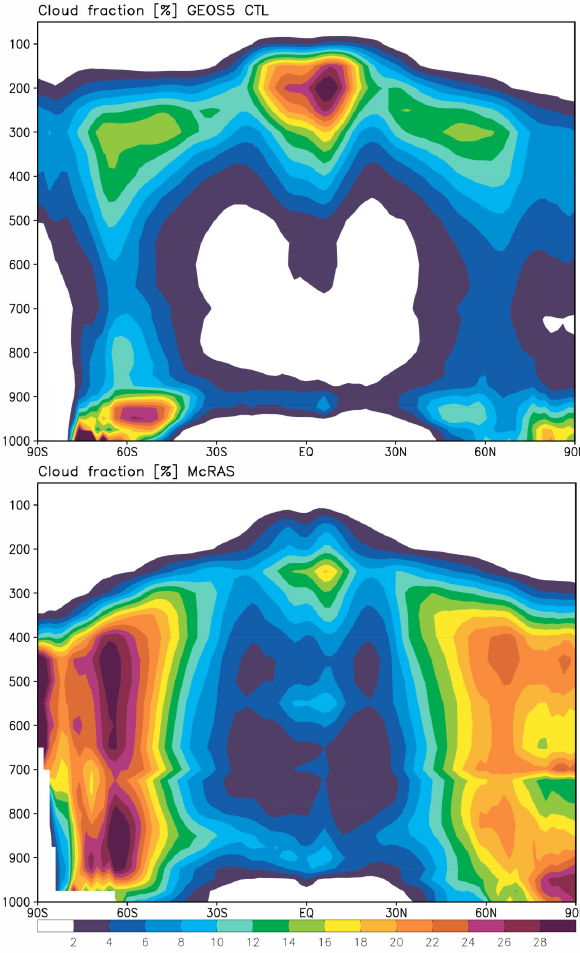
Fig. 9. Annually- and zonally-averaged cloud fraction profiles (on a scale 0–100) for the CTL and McRAS-AC cloud